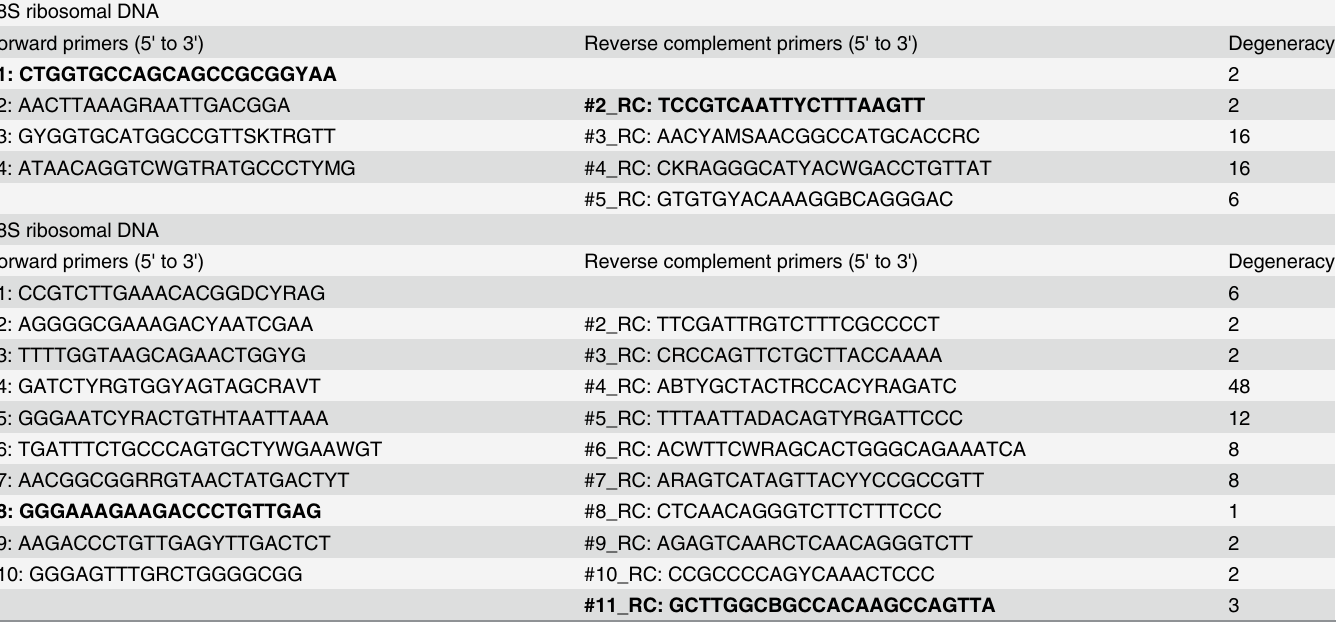
Table 1. List of the 18S and 28S ribosomal DNA primers designed in this study. Primers 28S #6, 28S #8, and 28S #10 were modified from primers 22, 24, 26 [21] , respectively. Primers ultimately selected for best overall efficacy are highlighted in bold. 18S ribosomal DNA Forward primers (5' to